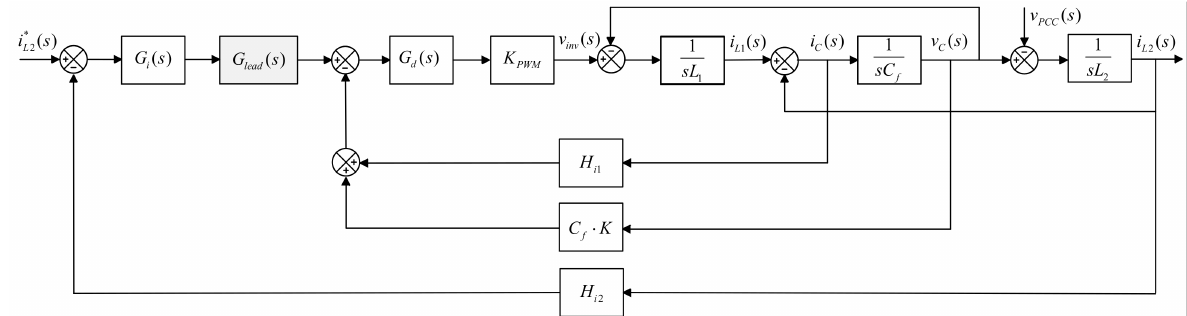
Figure 10. Block diagram of the proposed method in continuous-time